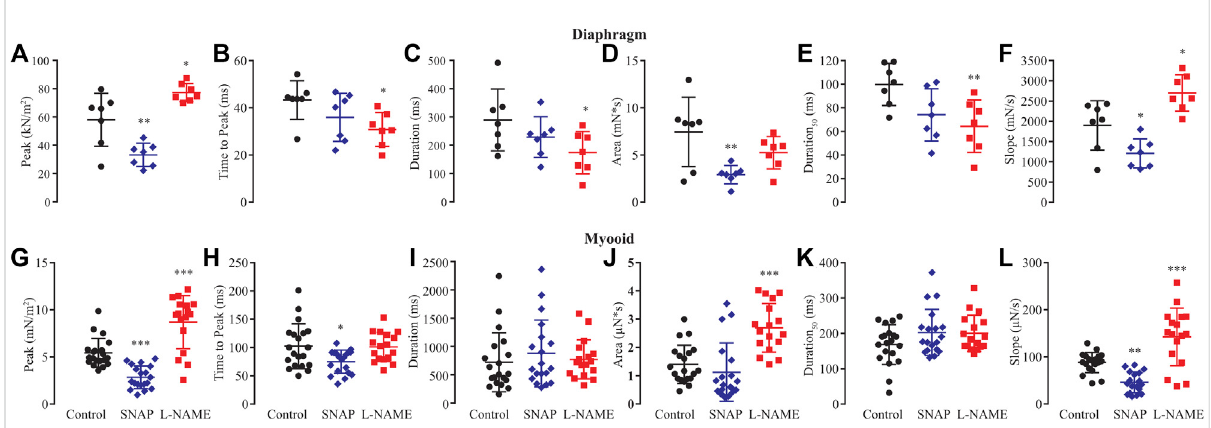
FIGURE 4 SummaryoftheeffectofSNAP(red)andL-NAME(blue)onbiophysicalparametersobtainedfromsixdiaphragmstripsandtwentymyooidsafter a single-twitch stimulation. The control data are represented in black. Panels (A) through (F) represent the six biophysical parameters analyzed for diaphragmstrips,while (G – L) isthesummaryanalysisforthemyooids.Theparametersanalyzedwerepeak (A,G) ,timetopeak (B,H) ,durationof95% of the response (C,I) , area under the curve of the response (D,J) , duration at 50% of the peak (E,K) and slope of the rising force production after the electrical stimulation (F,L) . The symbols *, **, and *** represent the signi fi cant thresholds below 5%, 1%, and 0.1%,